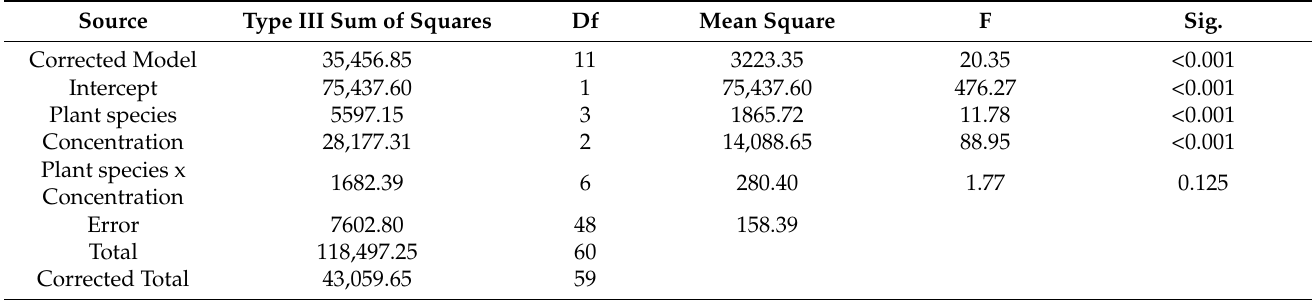
Table 4. Two-Way ANOVA for deterrent activity of the tested four plant essential oils on A. punicae .